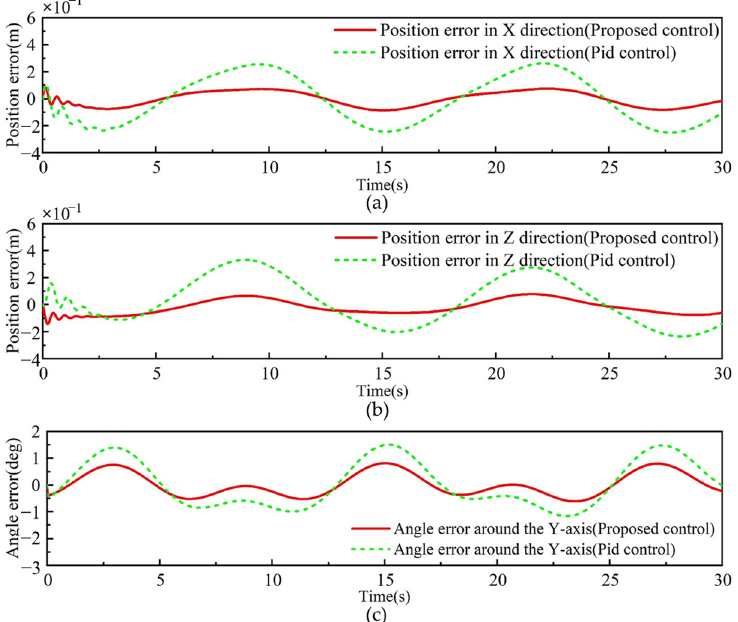
Figure 11. Comparison of tracking error of different controllers at v = 6.3 m/s: ( a ) Position error in X direction; ( b ) Position error in Z direction; ( c ) Angle error around the Y ‐ axis.